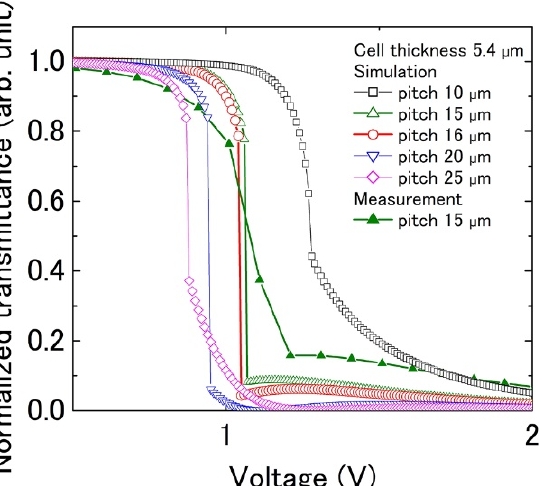
Figure 7. Transmittance as a function of applied voltage for LPSTN with chiral pitches of 5, 10, 15, 20, and 25 µ m. Open symbols indicate simulation data and solid symbols show measurement data.